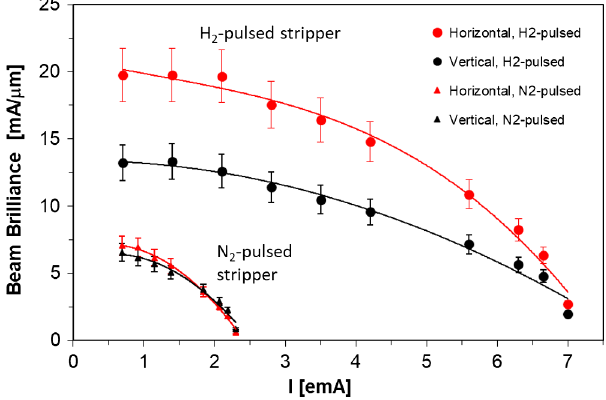
FIG. 4. Beam brilliance analysis for a 238 U 28 þ beam on a N 2 - or a H 2 -stripper